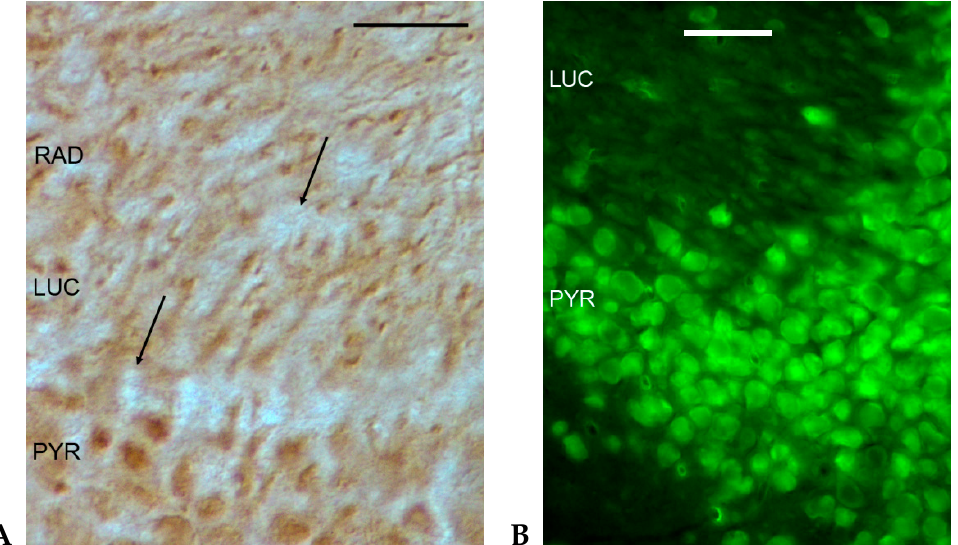
Figure 2. Immunohistochemical localization of GluK1 ( A ) and GluK2 ( B ) antibodies in the CA3 region of the murine hippocampus. The immunohistochemical picture suggests mainly postsynaptic GluK1 and GluK2 localization. PYR: pyramidal layer; LUC: stratum lucidum; RAD: stratum radiatum. Arrows on Figure 2A point to unstained mossy fiber terminals. See Appendix for methods. Bars: 50